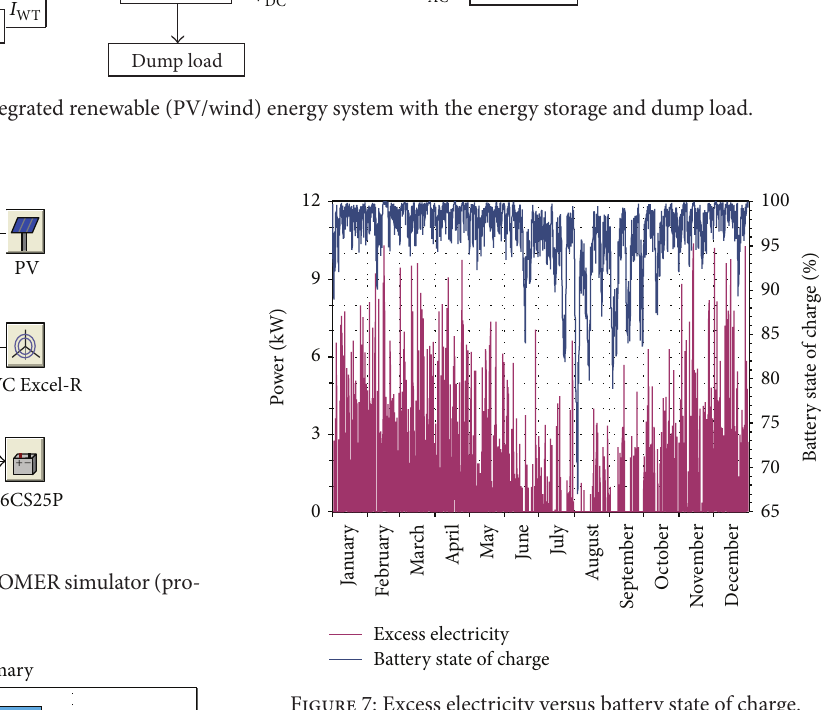
Figure 7: Excess electricity versus battery state of charge.